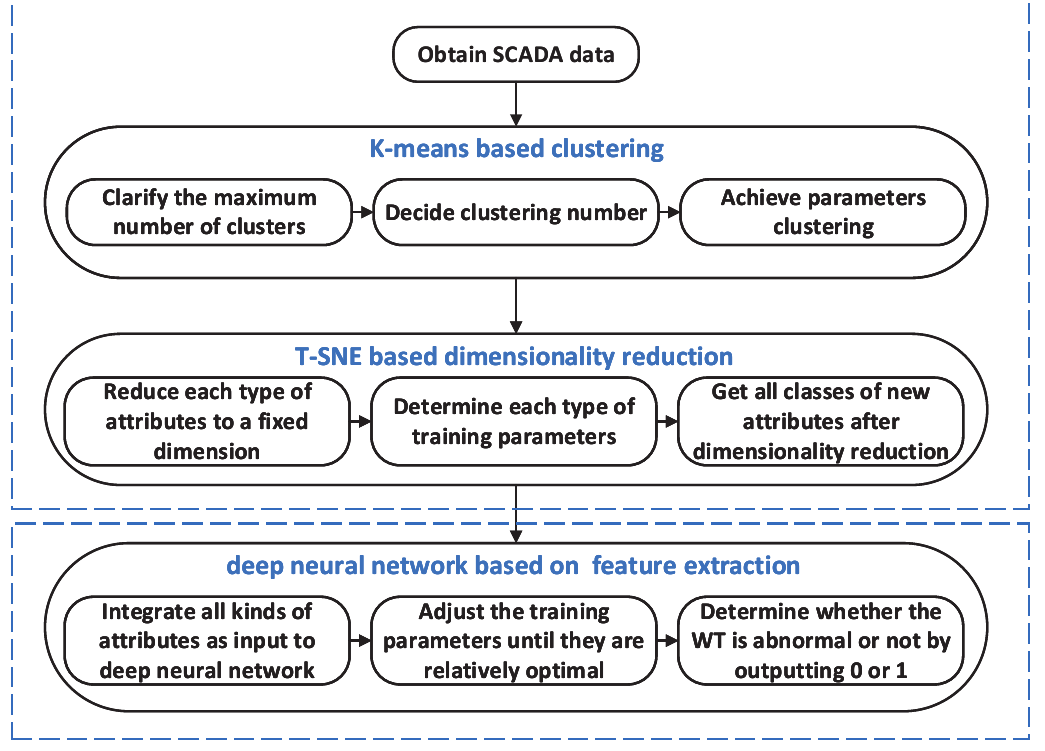
Figure 2. Flowchart of the proposed anomaly detection